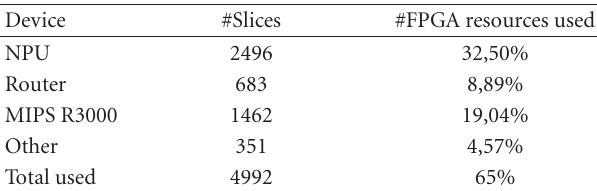
Table 3: FPGA synthesis result.